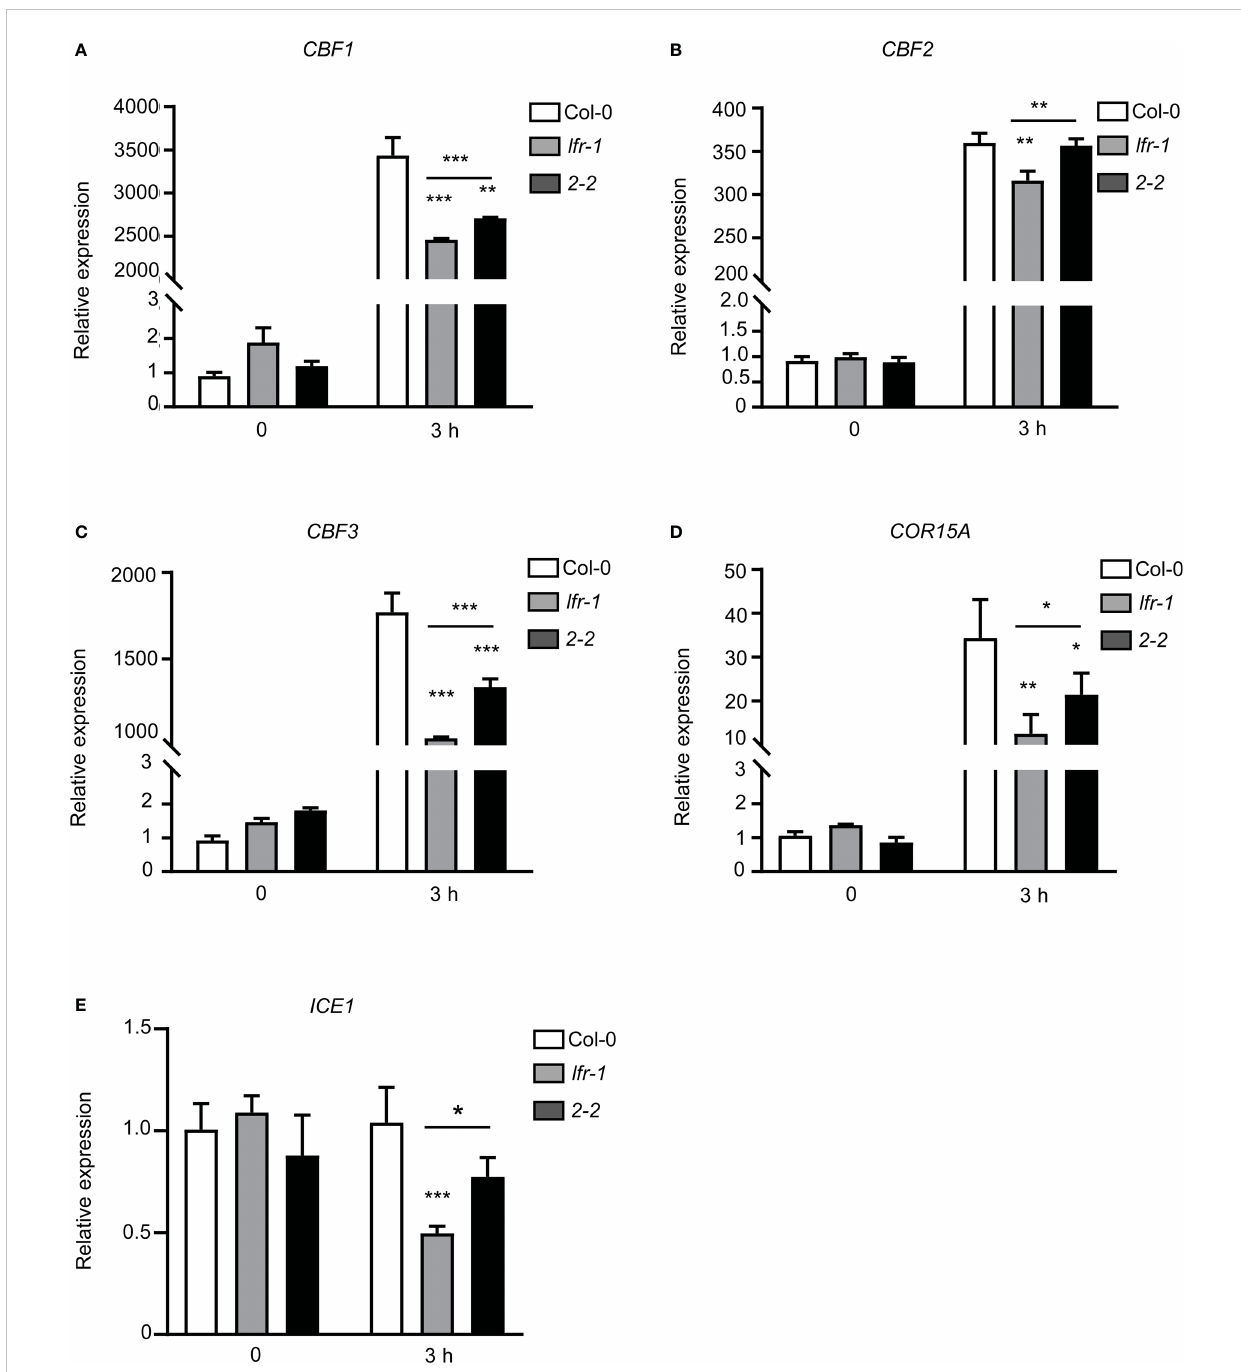
FIGURE 2 RT-qPCR analysis of CBFs and COR genes expression. (A – E) RT-qPCR data showing the transcript levels of CBF1 (A) , CBF2 (B) , CBF3 (C) , COR15A (D) , and ICE1 (E) in Col-0, lfr-1 , and complemented transgenic line (2-2). Eight-day-old seedlings were treated at 4°C for the indicated time periods. Error bars indicate the SD of three biological replicates. Statistically signi fi cant differences are indicated by asterisks (*P < 0.05, **P < 0.01, and ***P < 0.001; Student ’ s t -test). eIF4A1 was used as an internal